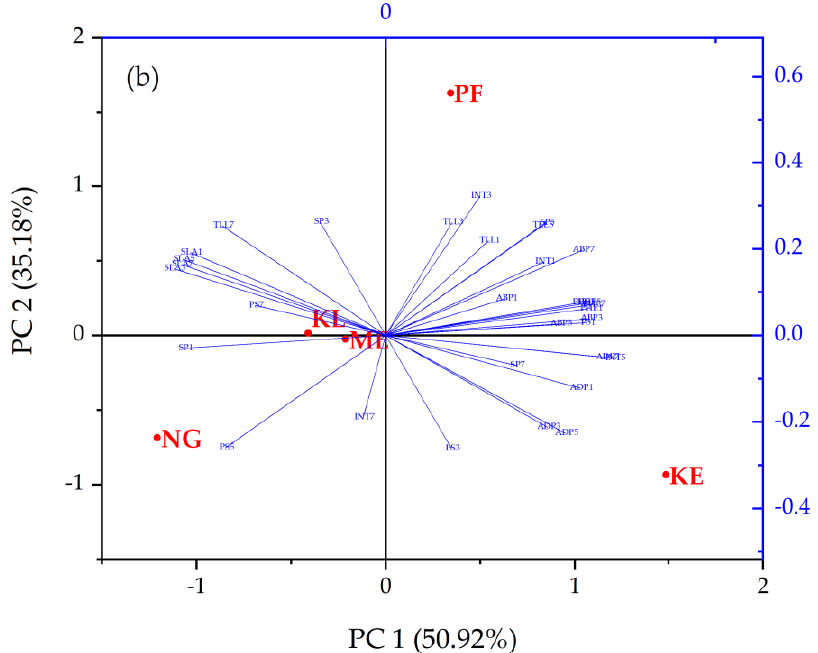
Figure 5. ( a ) Visualization of PCA based on the considered morphological and physiological traits of successively grown expanded carob leaves from suburban (KE) and urban (ME, KL, NG, PF) sites, revealing the substantial grouping of compound leaves of C. siliqua derived from urban polluted sites (pink) versus suburban (grey) habitat. ( b ) PCA based on traits of carob leaflets from urban (ME, KL, NG, PF) and suburban (KE) sites depicted using red spots and letters; on the black axes, the principal components are presented, and via the blue axes, the contribution of each variable on the principal components. Blue lines assigned to the variables, represent principal component loadings associated with individual traits; at the edges of the blue lines, the numbers 1, 3, 5 and 7 (in blue) correspond to the foliar developmental stage, and the letters (in blue) indicate the considered variables, that is, the specific leaf area (SLA), thickness of lamina (TLL), thickness of palisade (PS) and spongy (SP) parenchyma, thickness of abaxial (ABP) and adaxial (ADP) periclinal walls, phenolic compounds (PHE) and mesophyll thickness (INT).